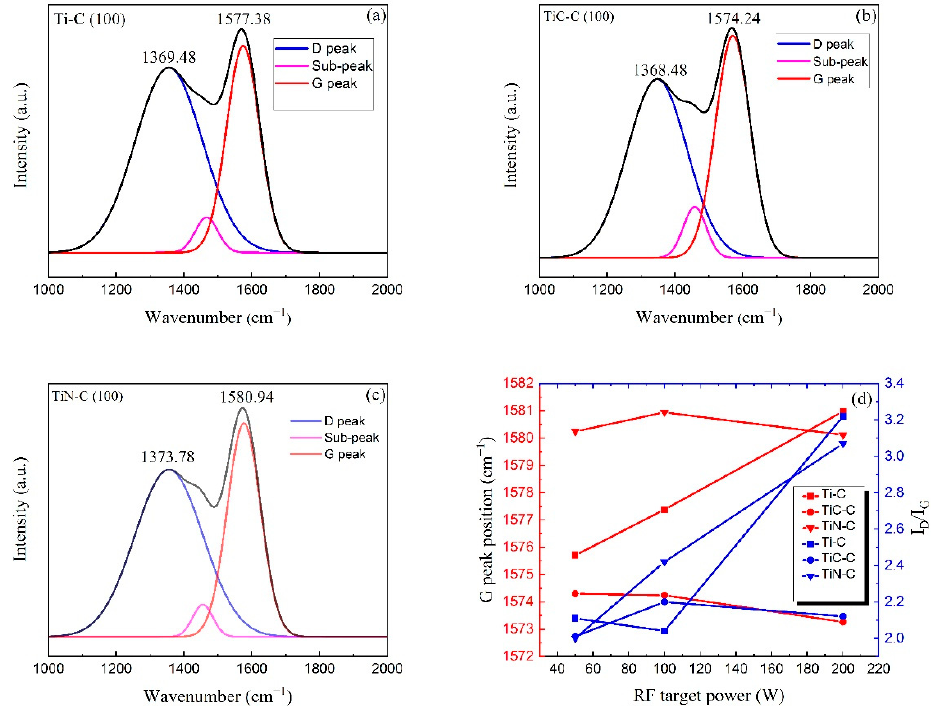
Figure 5. Raman analysis of (Ti:N)-GLC films: ( a ) Ti-C (100) spectrum; ( b ) TiC-C (100) spectrum; ( c ) TiN-C (100) spectrum; ( d ) G peak position with I D /I G vs. various RF target power.